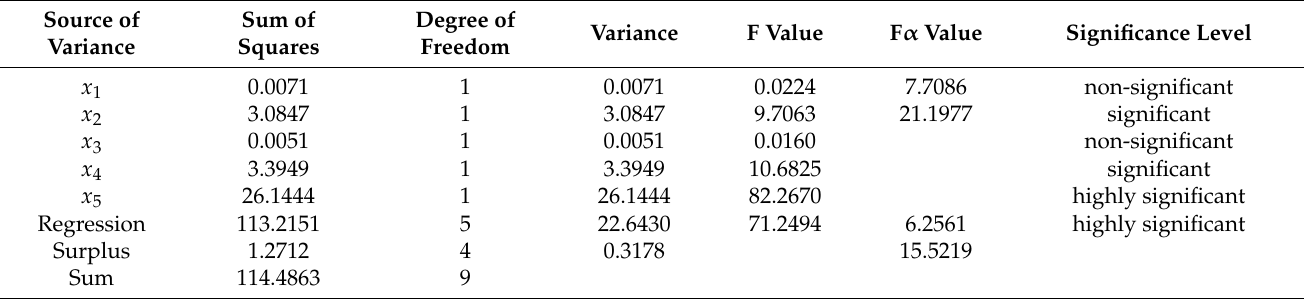
Table 3. Variance analysis results of influence of various factors on film lifting force index.